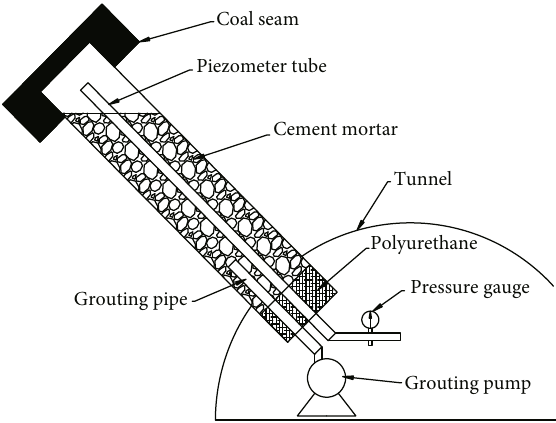
Figure 1: Schematic diagram illustrating direct determination of gas